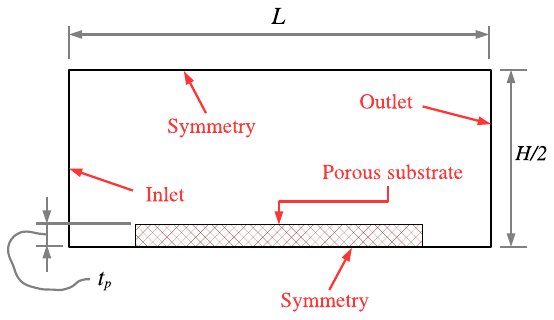
Figure 4. Sketch of the SCR channel model (dimensions are not in